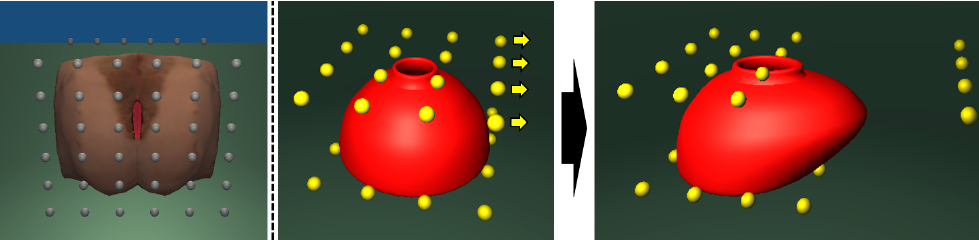
Figure 2. Vulva mesh model ( left ) embedded in a lattice of control points (grey). Cervix mesh model ( middle , red) embedded in a lattice of control points (yellow). Cervix mesh deformed by moving the control points ( right ).